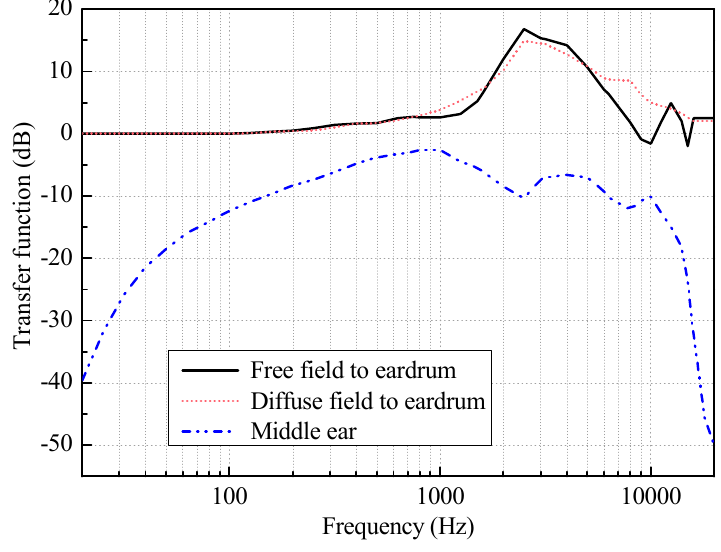
Figure A1. Transfer functions of the human ear.